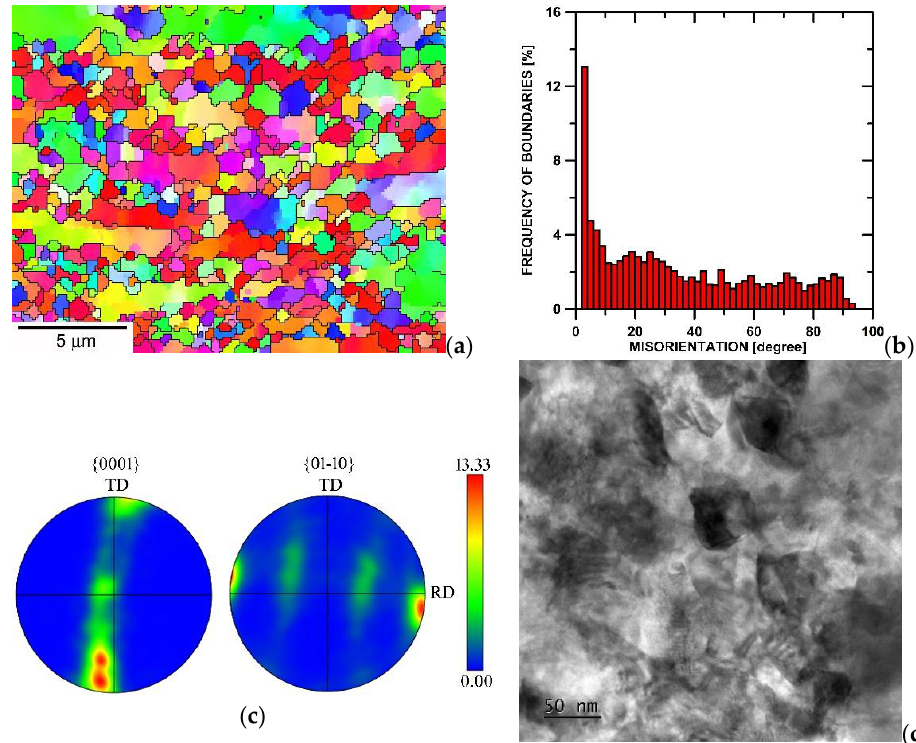
Figure 1. Microstructure of Ti ( a ) RT state, ( b ) grain boundary misorientation distribution for RT state, ( c ) pole figures for RT state, and ( d ) TEM micrograph of CT state.